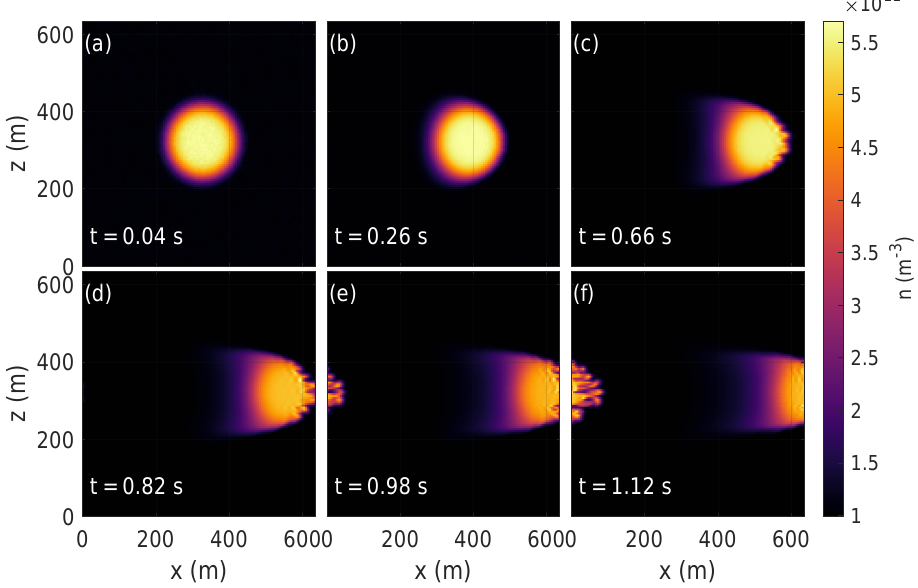
Figure 6. Density color plots of 2D slices at the mid-plane of ˆ y showing the evolution of a 3D plasma enhancement cloud simulation in a highly collisional regime in the xz plane. Panel ( b ) shows the cloud drifting along the ˆ x direction. Panels ( c , d ) show the formation of leading edge fingers in the x − z plane. Panels ( e , f ) show the continued growth of these finger-like structures as the cloud elongates along the ˆ x